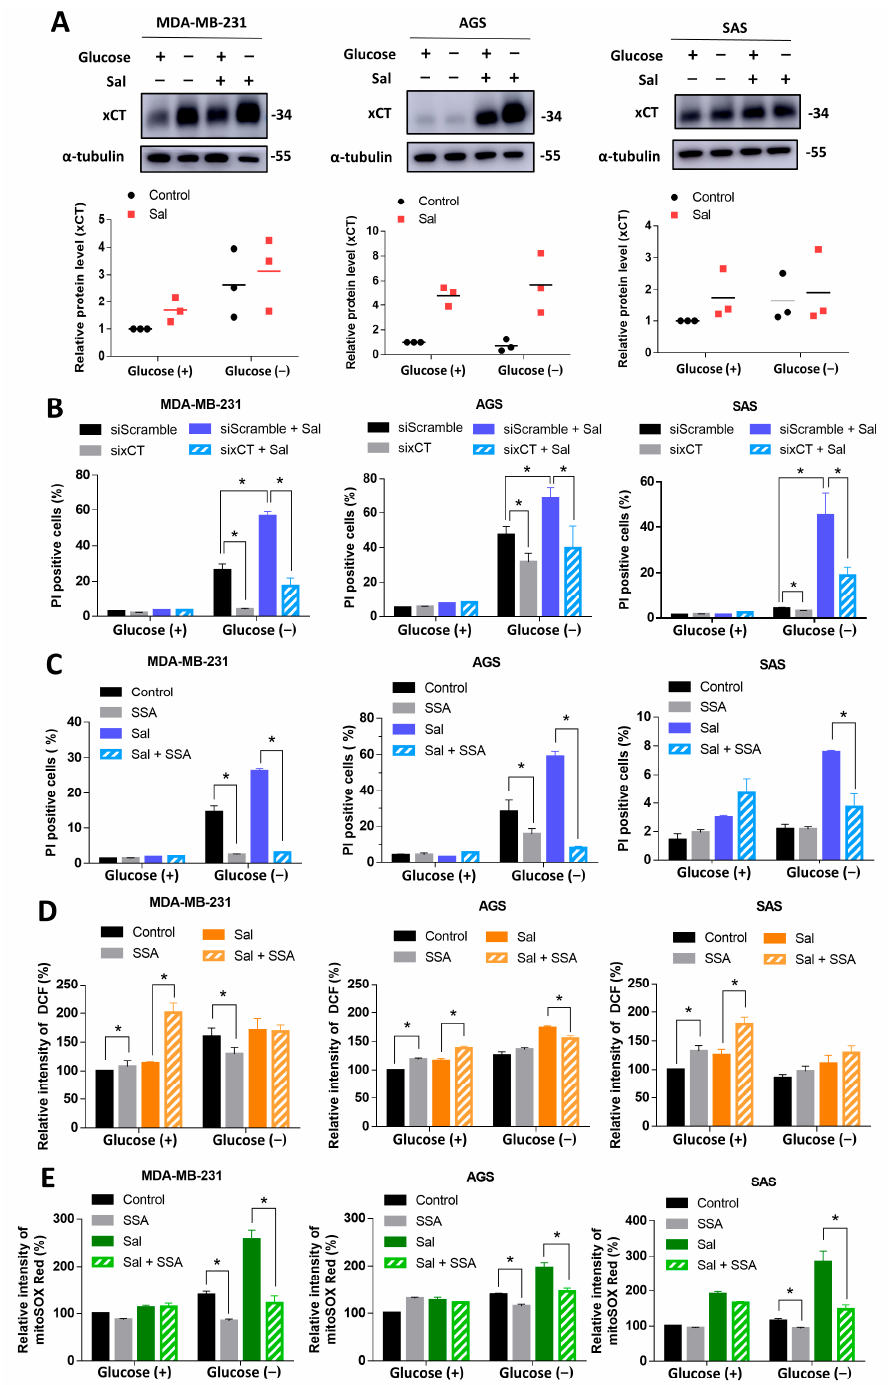
Figure 4. Salubrinal enhanced cell death during glucose deprivation through the upregulation of xCT. The cells were treated according to the study design with or without 30 µ M of salubrinal, siRNAs against xCT (sixCT), or 350 µ M of sulfasalazine for 24 h. ( A ) The protein levels of xCT were detected using Western blotting. The value of the control group under glucose-containing conditions was set as 1. The cell death rate was evaluated by a PI exclusion assay after the knockdown of xCT by sixCT ( B ) or the supplementation of sulfasalazine ( C ). The levels of intracellular ROS (icROS) and mitochondrial ROS (mtROS) were detected using flow cytometry with DCFH-dA staining ( D ) and mitoSOX Red dye ( E ). The value of ROS measured from the control group under glucose-containing conditions was normalized to 100%. The data are presented as the means ± SEMs of the results from three independent experiments. * p < 0.05. SSA: sulfasalazine. Sal: salubrinal. Glucose (+): medium with 25 mM of glucose. Glucose ( − ): glucose-free